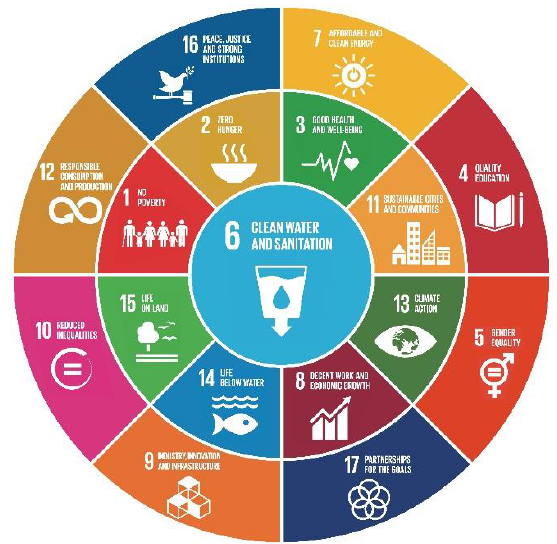
Figure 2. The water centric 17 Sustainable Development Goals.